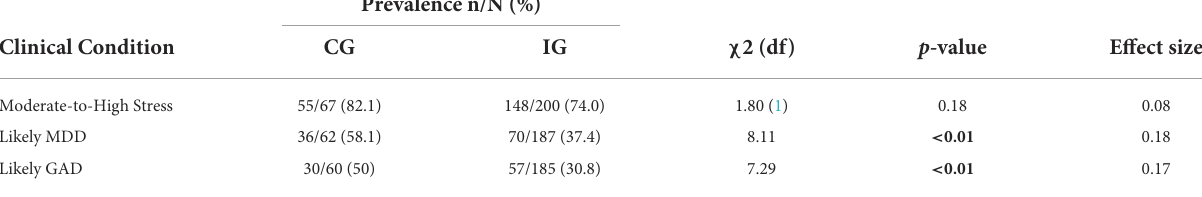
TABLE 3 Chi-square test of association between prevalence of clinical parameters and study